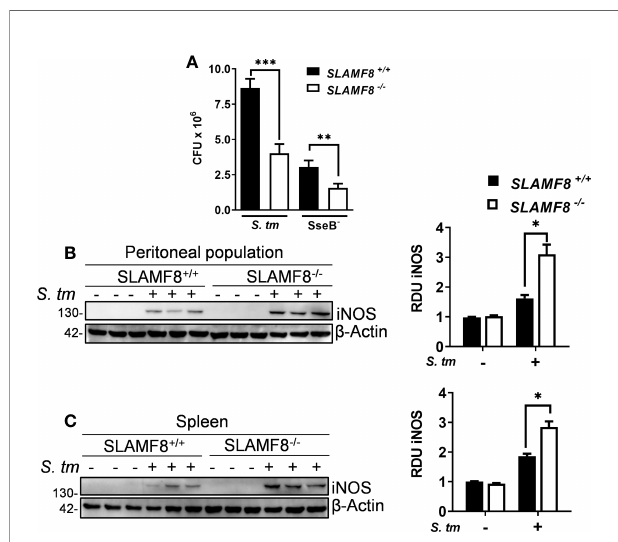
FIGURE 10 | SLAMF8 -/- mice exhibit greater bactericidal activity and NOS induction upon S. typhimurium infection in vivo . (A) Analysis of bactericidal activity in SLAMF8 +/+ and SLAMF8 -/- mice. Mice were injected i.p. with wild-type S. typhimurium and attenuated SseB - strains (5 × 10 4 CFUs) and subsequently sacri fi ced, and serial dilutions of spleen homogenates were plated on LB agar plates with and without ampicillin (100 ng/ml). Values indicate mean ± SEM of triplicate dilutions from one out of three independent experiments ( n = 5 mice per experiment). (B, C) Analysis of microbicidal mechanisms in SLAMF8 +/+ and SLAMF8 -/- mice. Mice were infected with S. typhimurium (5 × 10 4 CFUs) or uninfected (PBS). (B) Peritoneal population and (C) spleen lysates from three individual mice were obtained, after 48 h of i.p. injection, and subjected to Western blotting for the indicated proteins (left). Relative expression levels were normalized using b -actin as the loading control, and graphically represented (right). Values indicate mean ± SEM of three individual mice used in one out of two experiments. * p < 0.05; ** p < 0.01; *** p < 0.001. RDU, relative densitometry units; CFU, colony-forming